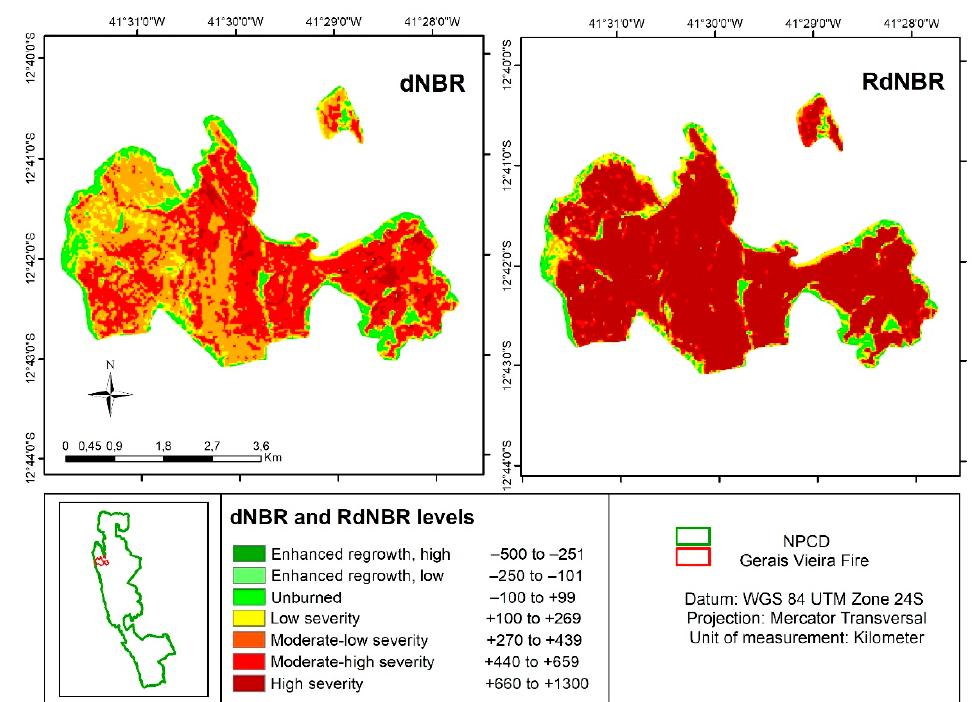
Figure 6. The severity of the burnt area identified by the dNBR and RdNBR indices for the Gerais do Vieira fire (classification by Key and Benson [10]).